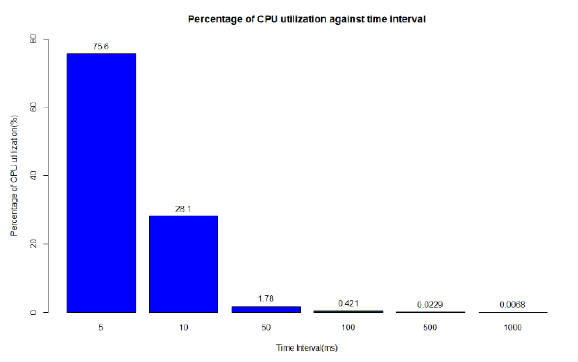
Figure 8 . Percentage CPU Utilization for different time intervals